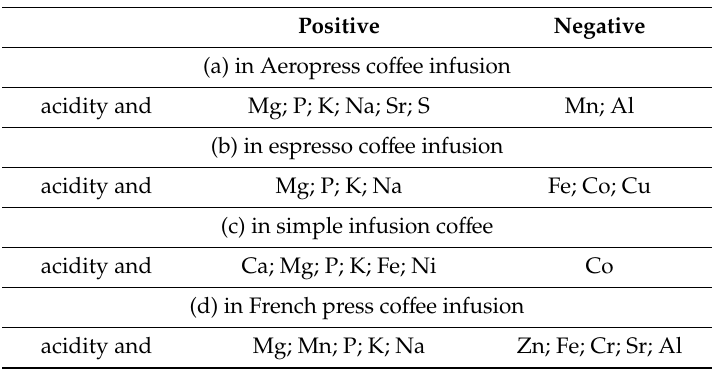
Table 4. Statistically significant (at p ≤ 0.05) correlation ( r ) between mineral content and acidity in co ff ee